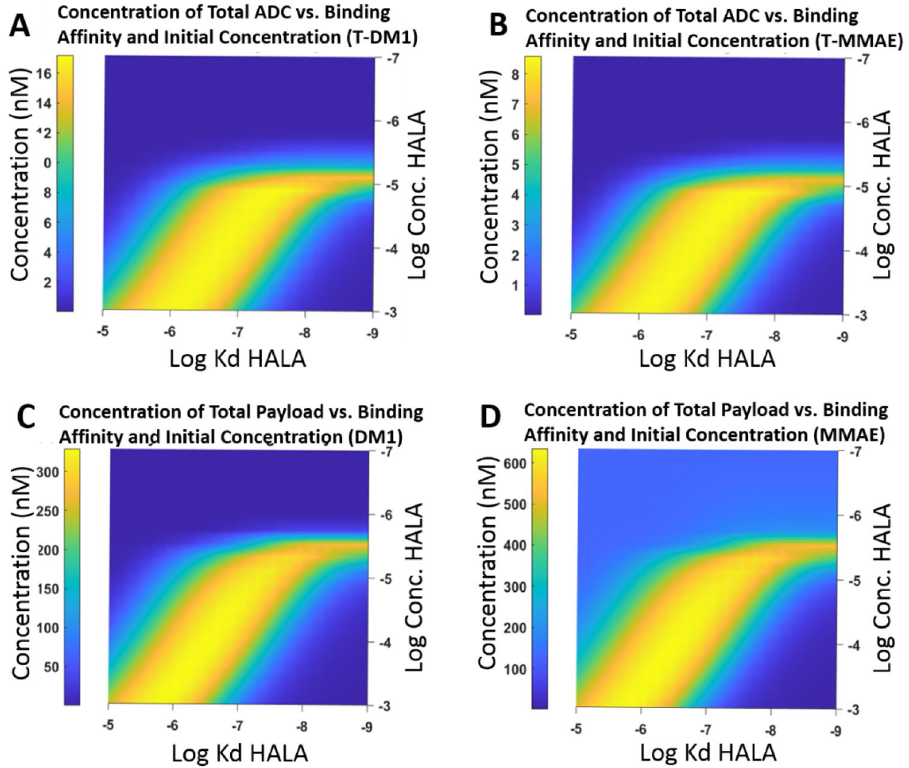
Figure 5. Distribution of ADC and Payload of co-administered ADC with HALA antibody showing changing concentration and binding affinity in Krogh Cylinder simulations after 48 h. ( A ) Distribution of ADC at a dose of 3.6 mg/kg with DM1 payload (non-bystander) ( B ) Distribution of ADC at a dose of 1.8 mg/kg with bystander (MMAE) payload. ( C ) Payload distribution of ADC with non-bystander payload. ( D ) Payload distribution of ADC with bystander payload. The lighter blue region above the yellow curve in D has a higher concentration due to MMAE bystander payload distribution. Concentrations are shown at the Krogh cylinder radius, R Krogh , far from tumor blood